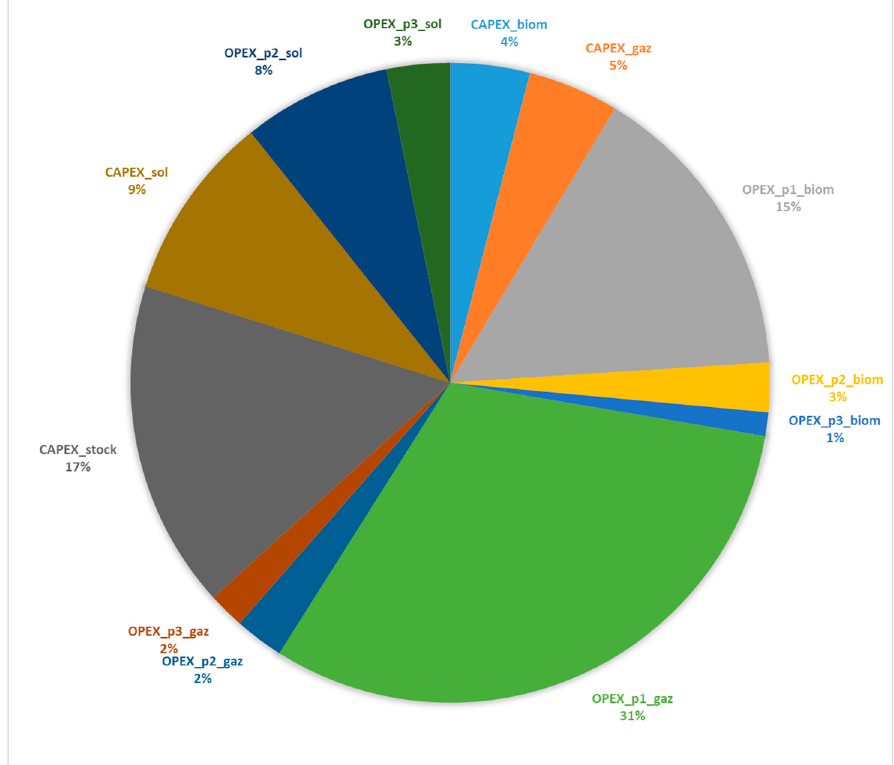
Figure 17. Distribution of costs over the whole lifespan (connection 1).